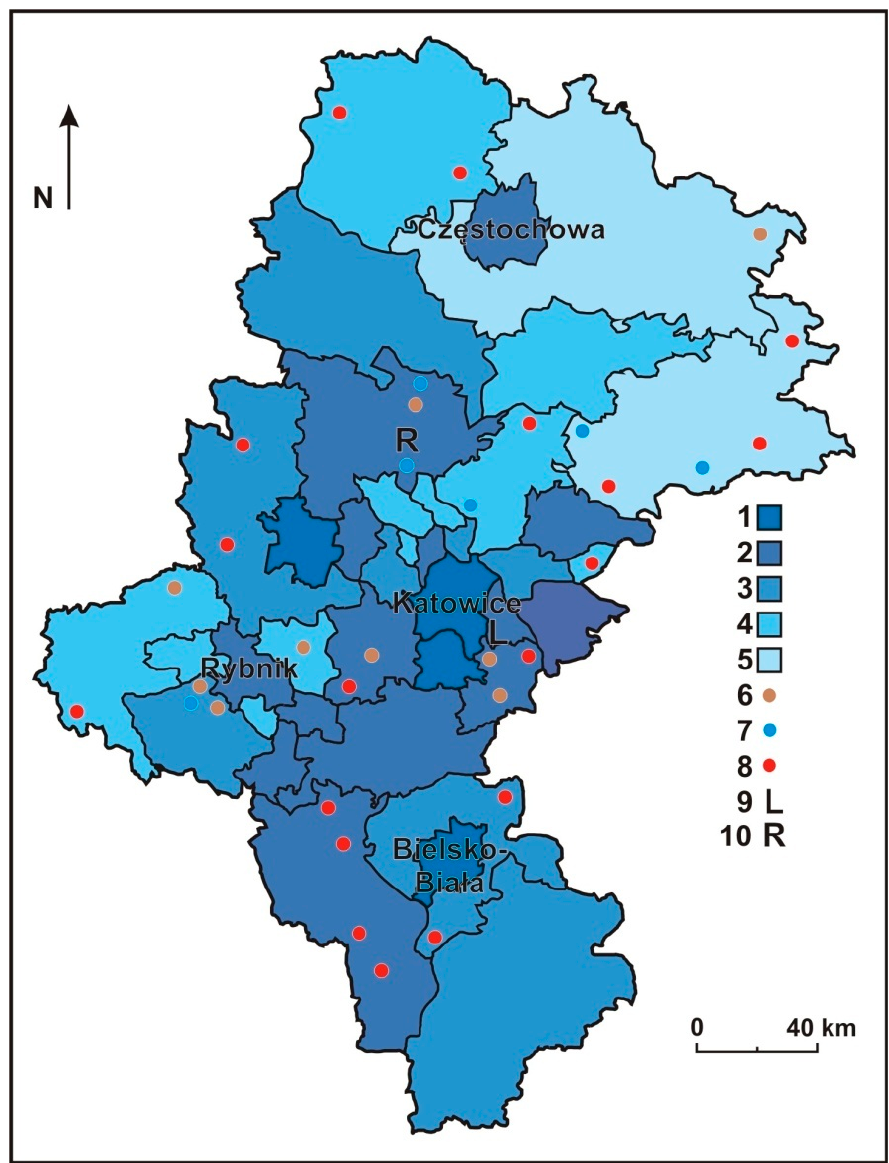
Figure 1. The rate of territorial development (RTD) for the attributes of The Modern Economy in Silesian province in 2012 (illustration sourced by [54]—the RTD rate and authors—types of towns). Explanations: The RDT rate: 1—very high; 2—high; 3—average; 4—low; and 5—very low; types of towns: 6—industrial towns; 7—postindustrial small towns; and 8—other small towns (service or residential functions before economic transformation; L—L ę dziny; R—Radzionków.